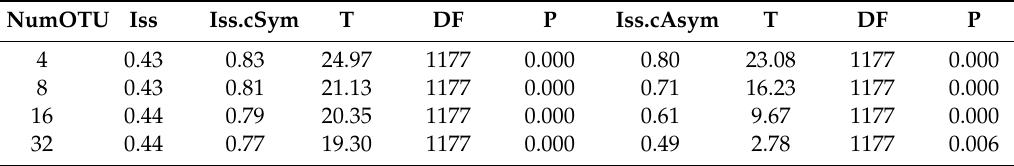
Table 1. Results output for the substitution saturation test for COI implemented in DAMBE. NumOTU = OTU subset number, Iss = simple index of substitution saturation, Iss.cSym = critical index of substitution saturation assuming symmetrical tree topology, Iss.cAsym = critical index of